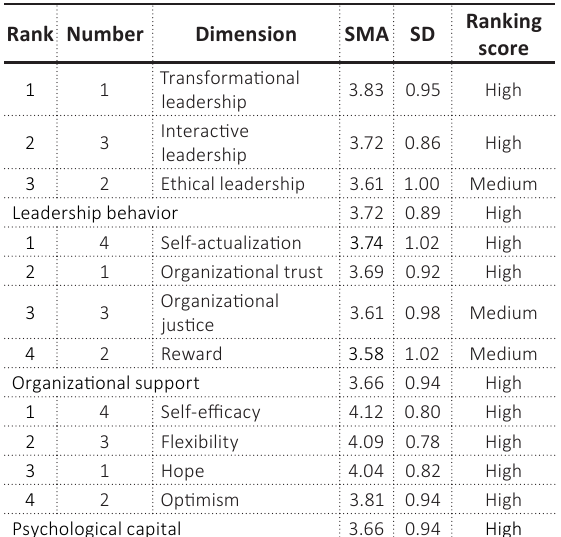
Table 2. Means and standard deviations of study